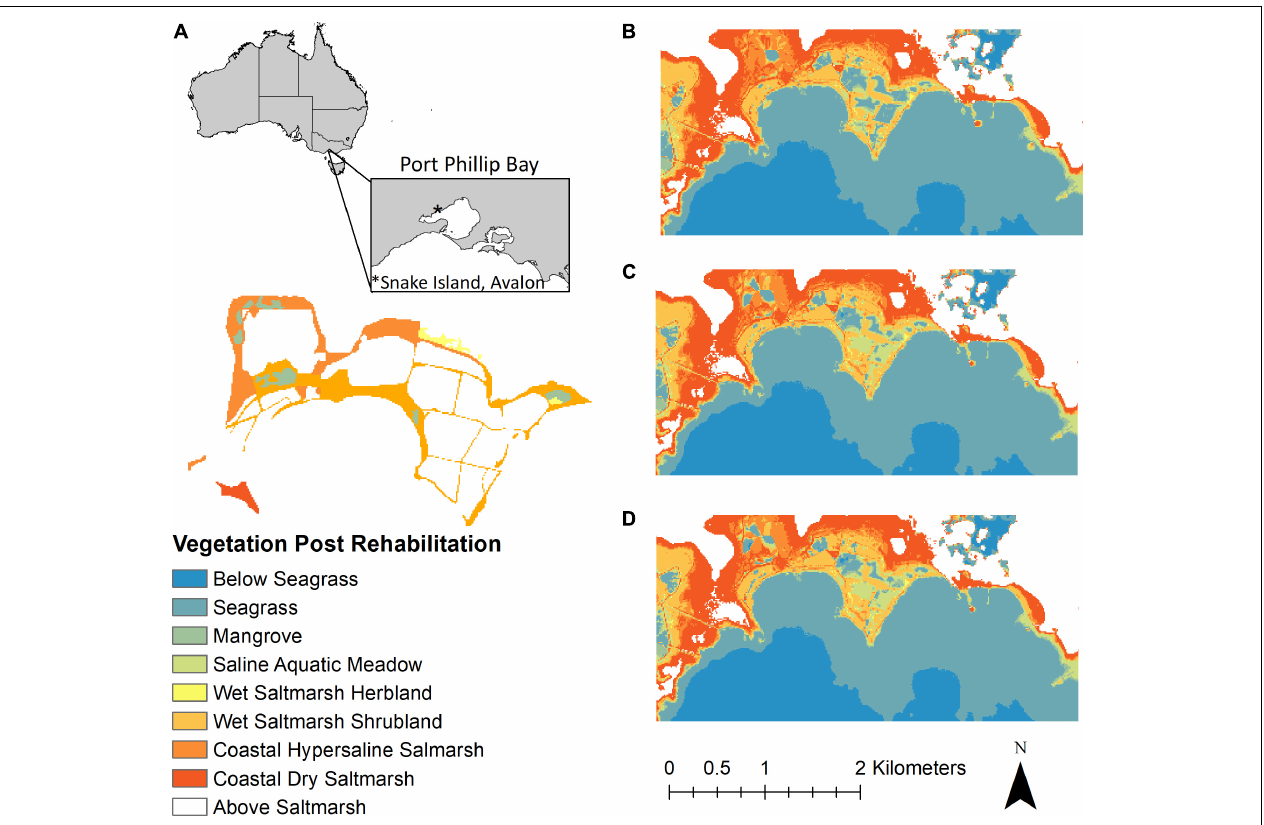
FIGURE 5 | (A) Current EVCs at the recovered site and salt ponds, the bare areas shown relate to the salt ponds. (B) DEM predicting the different tidal marsh EVCs, seagrass, and mangrove habitats following rehabilitation. (C) The DEM of the possible plant communities following an SLR of 0.4 m by 2100 (adjusted to 0.3 m allowing for sediment accretion). (D) Following an SLR of 0.8 m (adjusted to 0.7